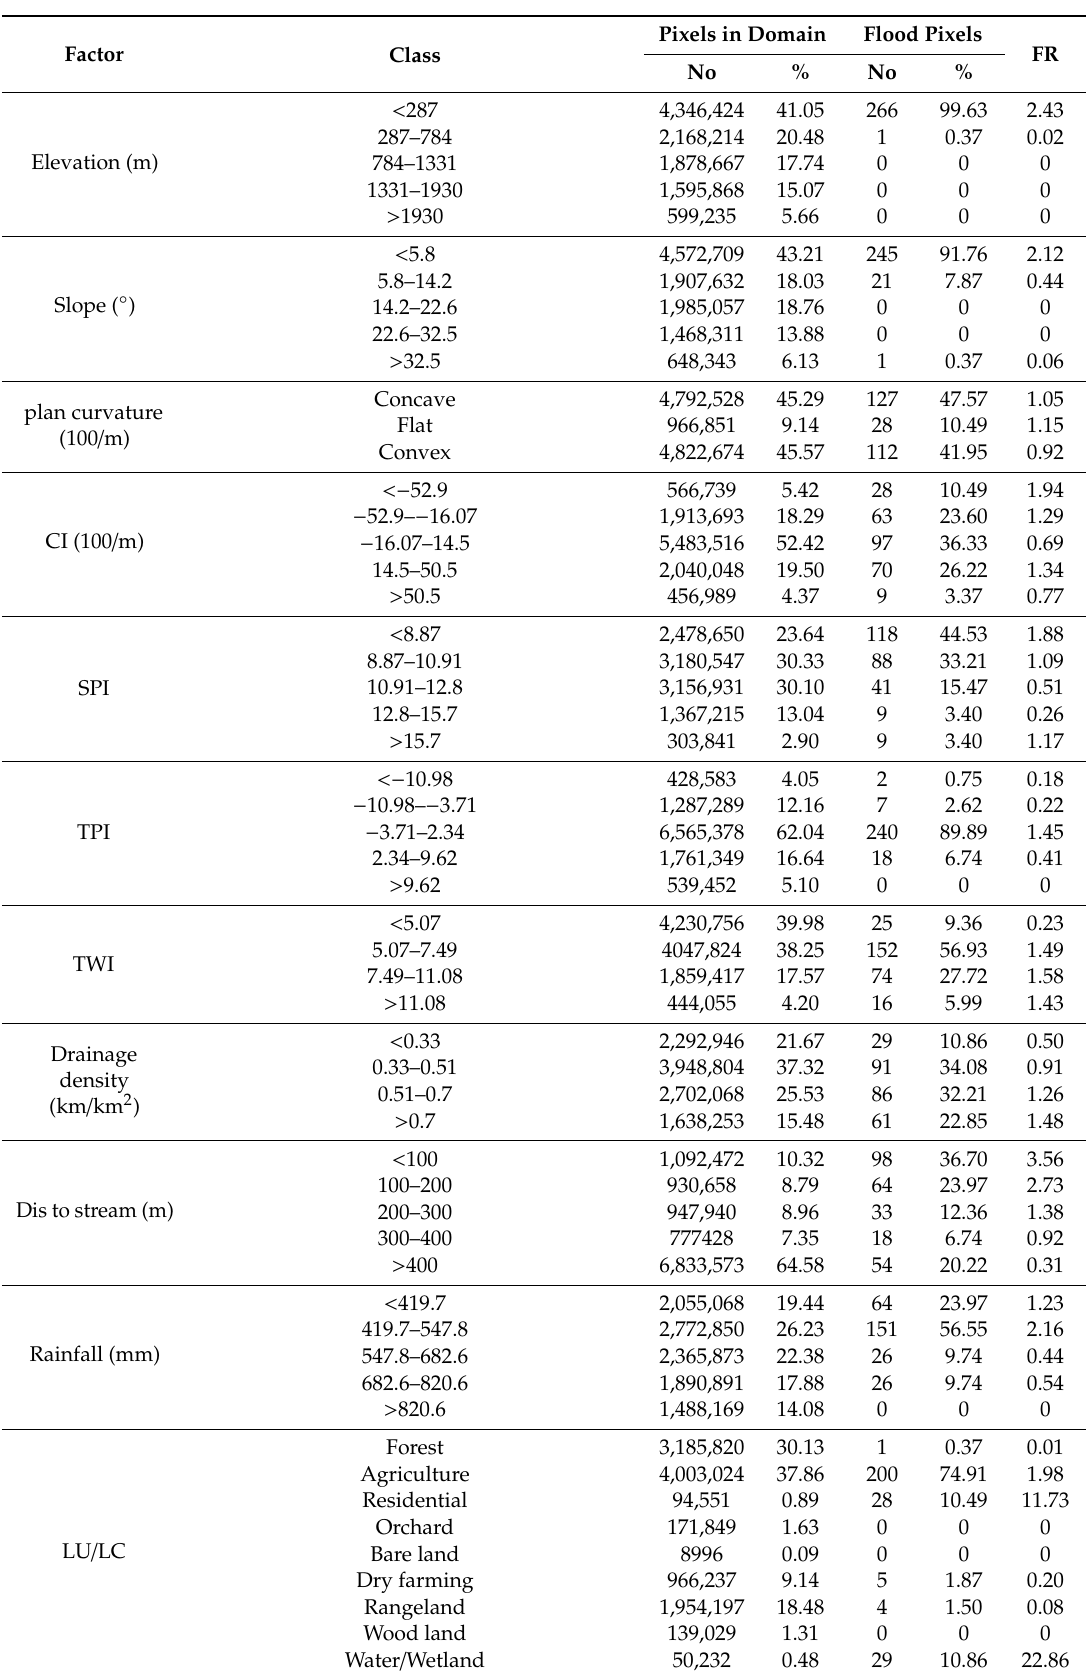
Table 2. Spatial relationship between conditioning factors and floods by frequency ratio